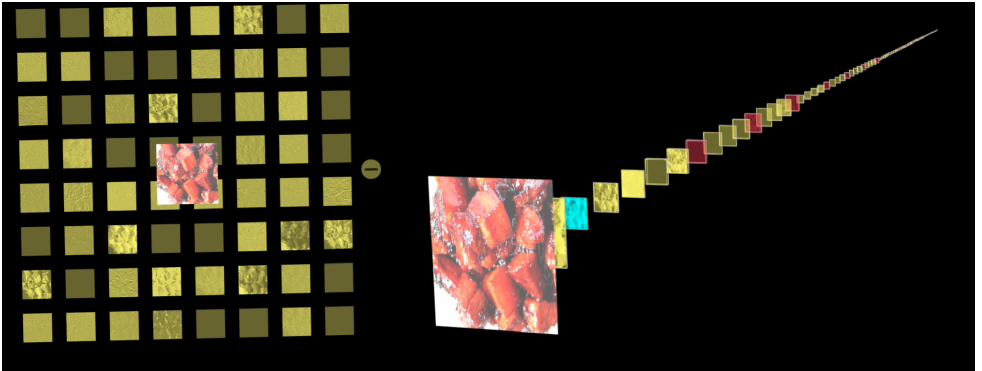
Figure 7. Integration of the proposed framework with mobile application and web.